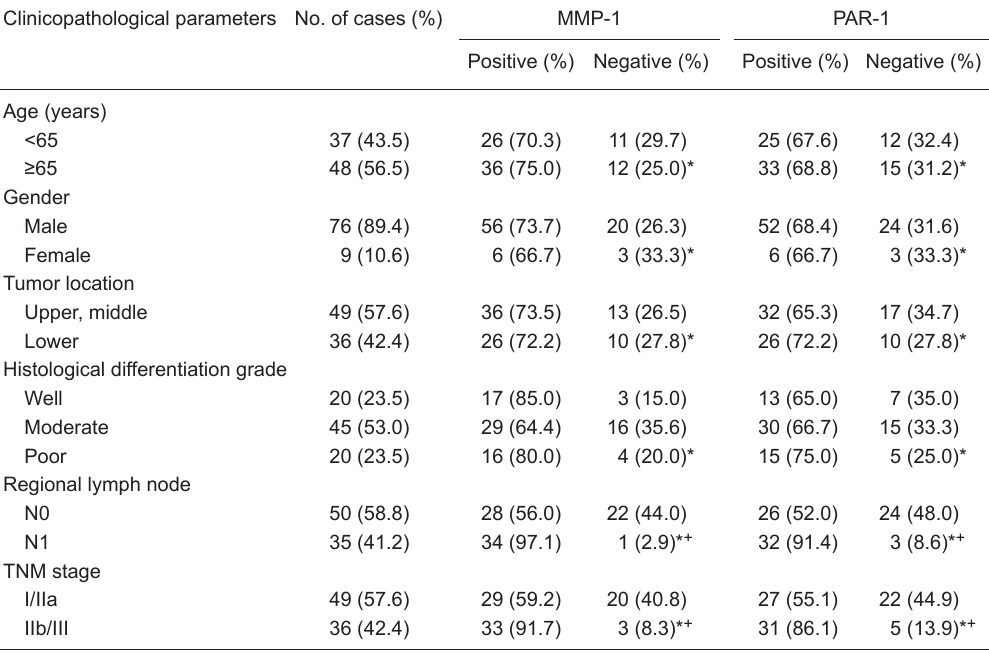
Table 1. Correlations of matrix metalloprotease-1 (MMP-1) and protease-activated receptor-1 (PAR-1) expression with the clinicopathological parameters of esophageal squamous cell carcinoma. Clinicopathological parameters No. of cases